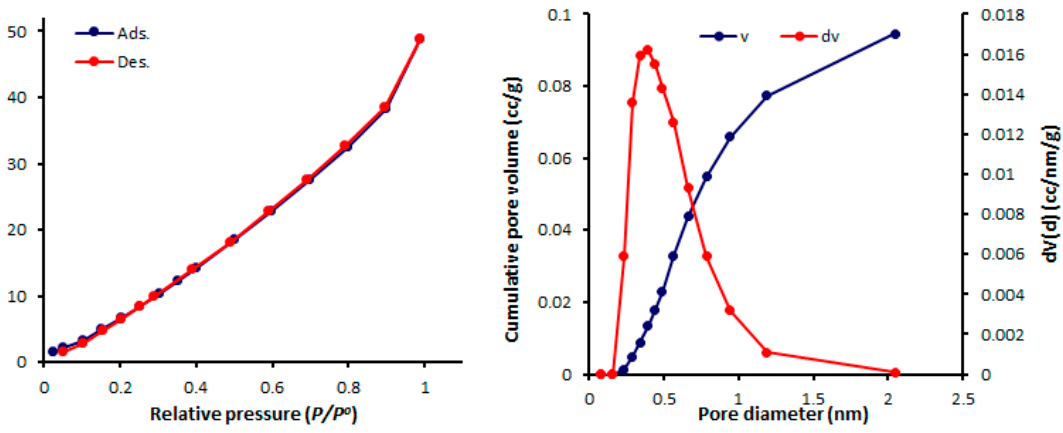
Figure 4. N 2 isotherms and pore diameters of 1 .